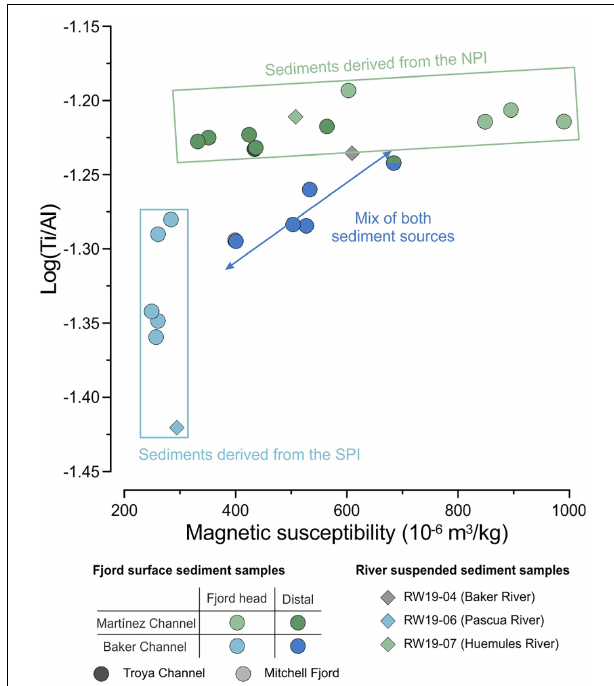
FIGURE 8 | Log(Ti/Al) vs. magnetic susceptibility of the fjord and river sediment samples. The green and blue rectangles represent sediments derived from the Northern (NPI) and Southern (SPI) Patagonian Icefields, respectively. RW19-05 is considered as an outlier (RESULTS section “Magnetic Susceptibility”) and was thus not included. Error bars are smaller than the size of the